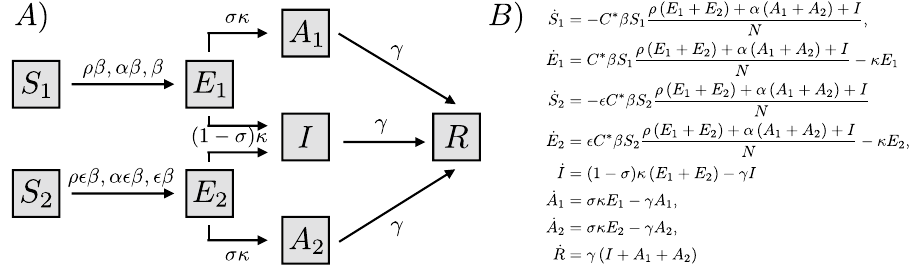
Figure 1. Constant contacts disease model. The affected population is divided into two behavioral groups: risk- takers (RT) and risk evaders (RE), denoted with the subscripts 1 and 2, respectively. Thus, S 1 , E 1 , and A 1 are the susceptible, exposed, and asymptomatic subpopulations of risk-takers, respectively; and similarly S 2 , E 2 , and A 2 for risk evaders. We consider a single symptomatic subpopulation since we assume homogeneous behavior of individuals in this health class.